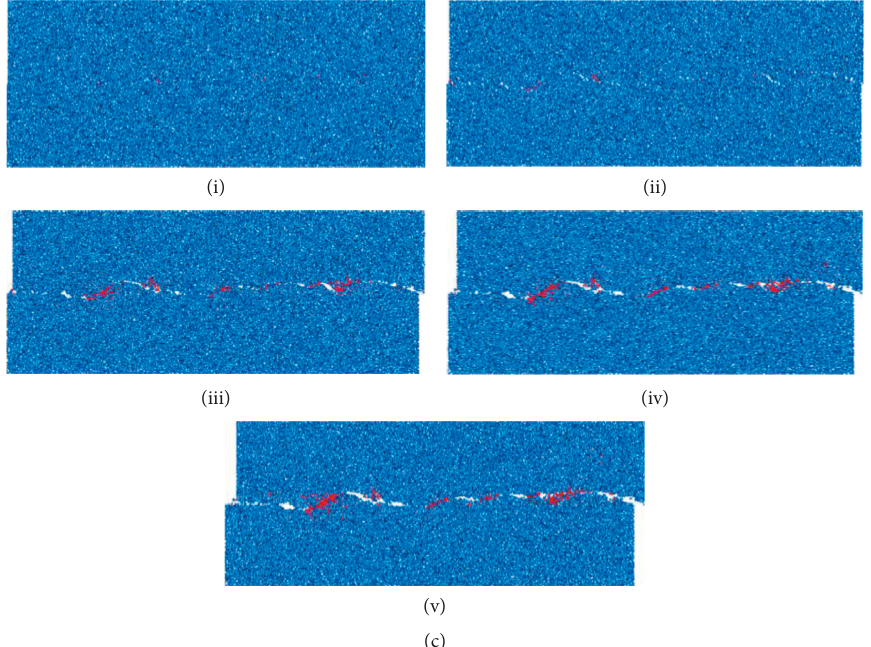
F IGURE 19: Simulation results of a jointed specimen with a JRC of 18–20 subjected to a normal stress of 3MPa. (a) Relationships of the shear displacement with the shear stress and fracture number. (b) Relationship between the normal and shear displacement. (c) Fracture characteristics during the shear process (red dots indicate the fracture location). Shear displacement: (i) 0.4 mm; (ii) 0.8mm; (iii) 1.6mm; (iv) 2.4mm; (v) 3.0mm.